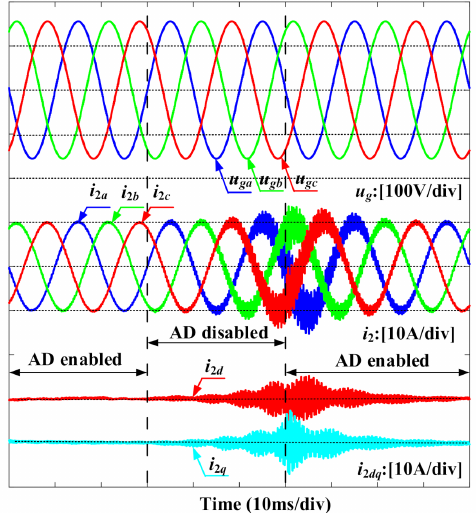
Figure 13. Comparison study for PCS with and without active damping algorithm.